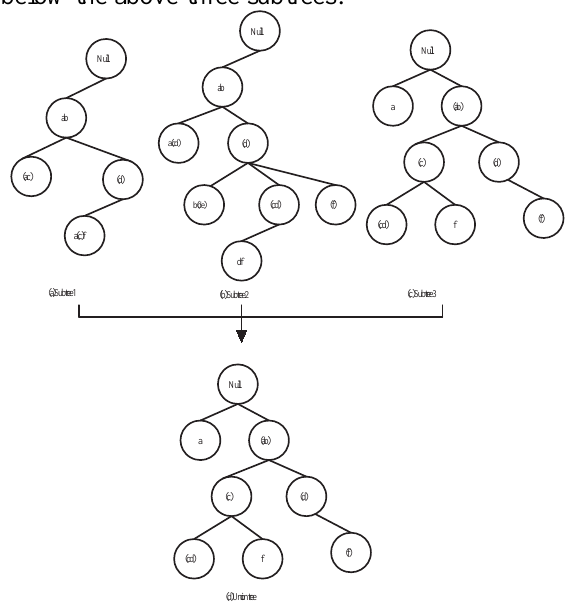
Fig. 2. Subtree union